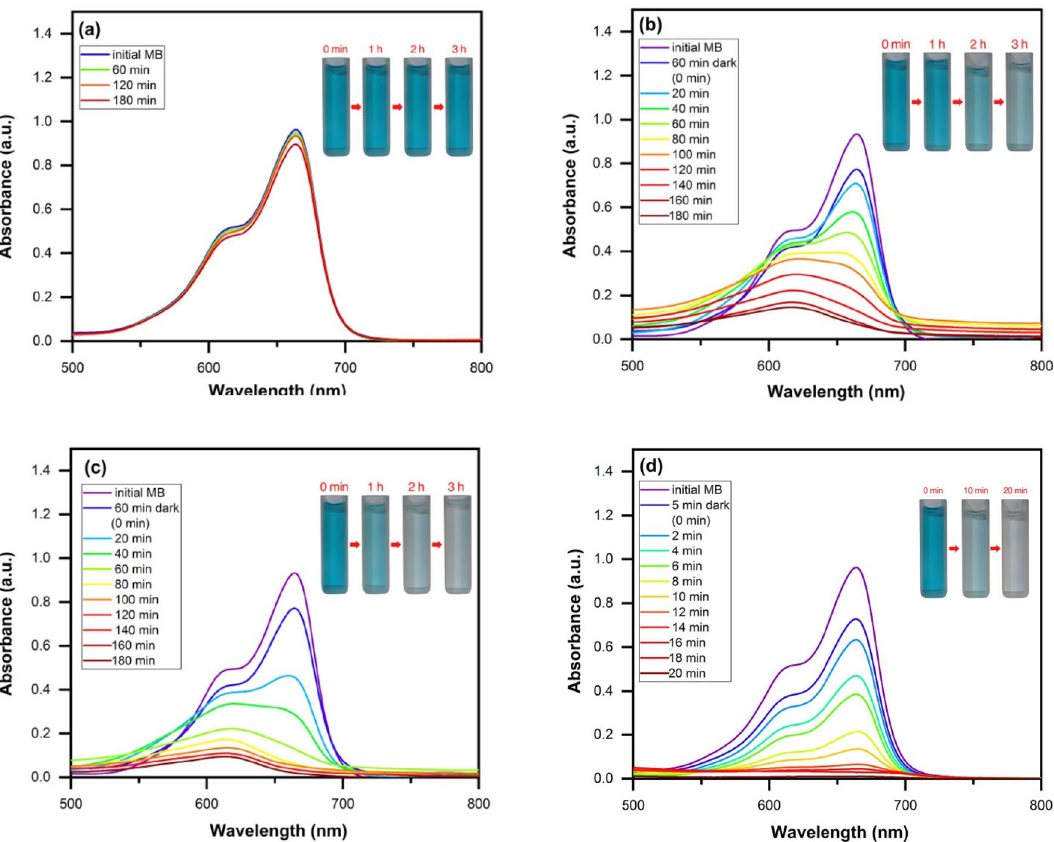
Figure 10. The absorption spectra of UV–Vis for MB dye degradation: ( a ) without catalyst for 180 min, ( b ) ZnO nanoparticles for 180 min, ( c ) ZnO/Chitosan for 180 min and ( d ) MWCNTs/ZnO/Chitosan for 20 min.